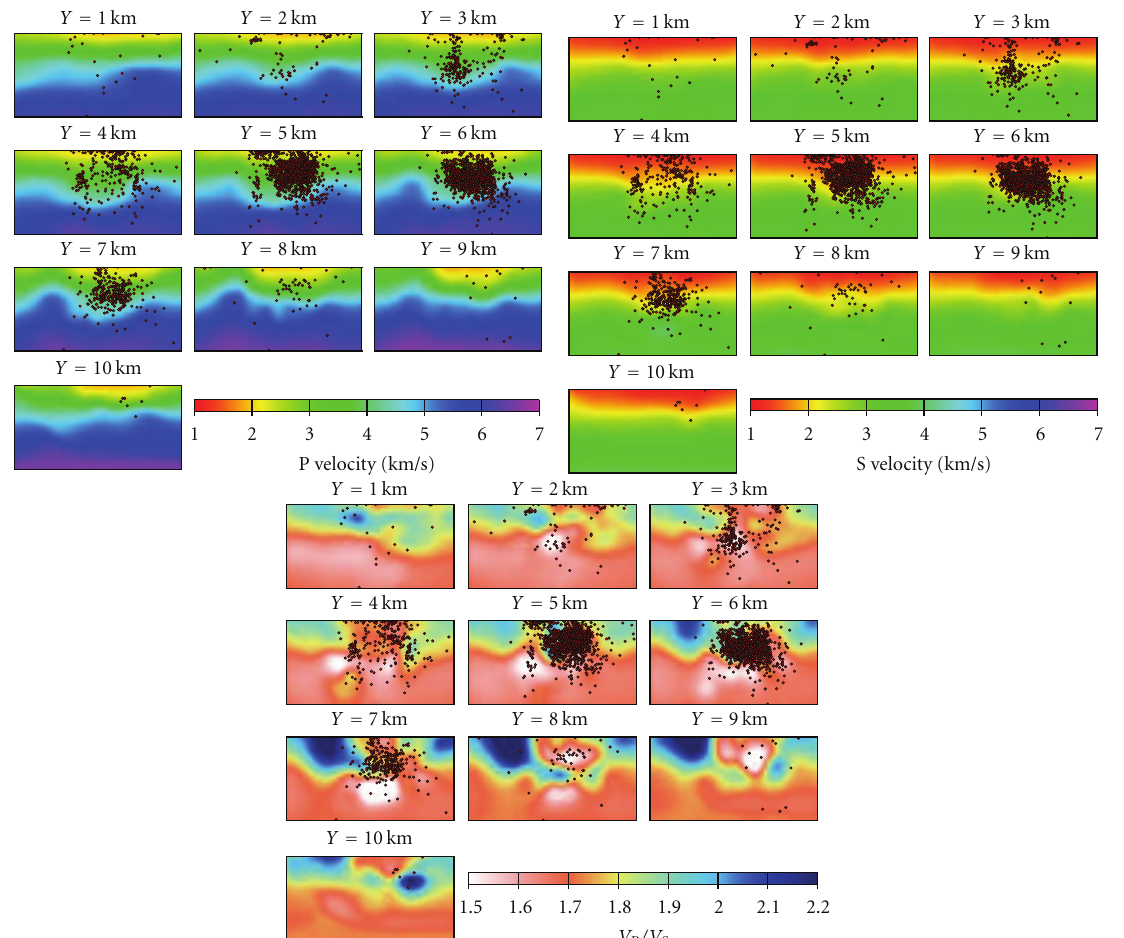
Figure 7: The most recent 3D tomographic model of the Campi Flegrei structure. This model has been obtained by merging SERAPIS model, obtained from the inversion of an active seismic dataset [16] and the LET model of Vanorio et al. [4]. The red dots represent the hypocentres of the 1982–1984 swarm located by Vanorio et al. [4]. See text for more details. This figure shows vertical, EW-oriented slices and can be compared directly to Figure 4. Axes scales are the same.